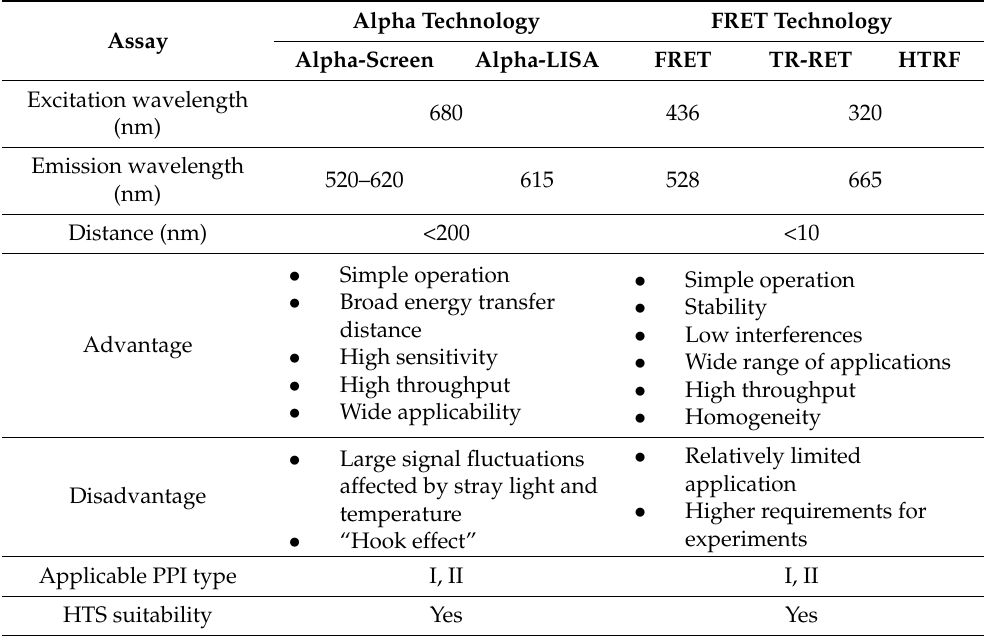
Table 1. Comparison of proximity-based analysis